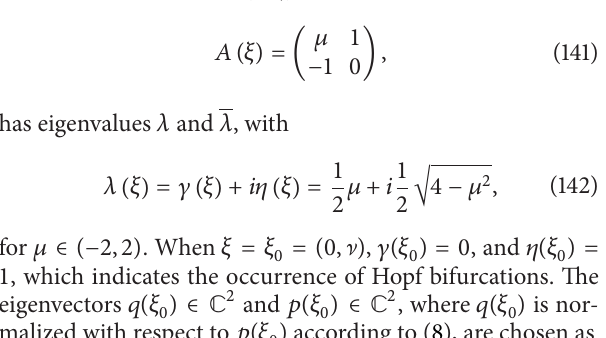
Figure 1: van der Pol circuit